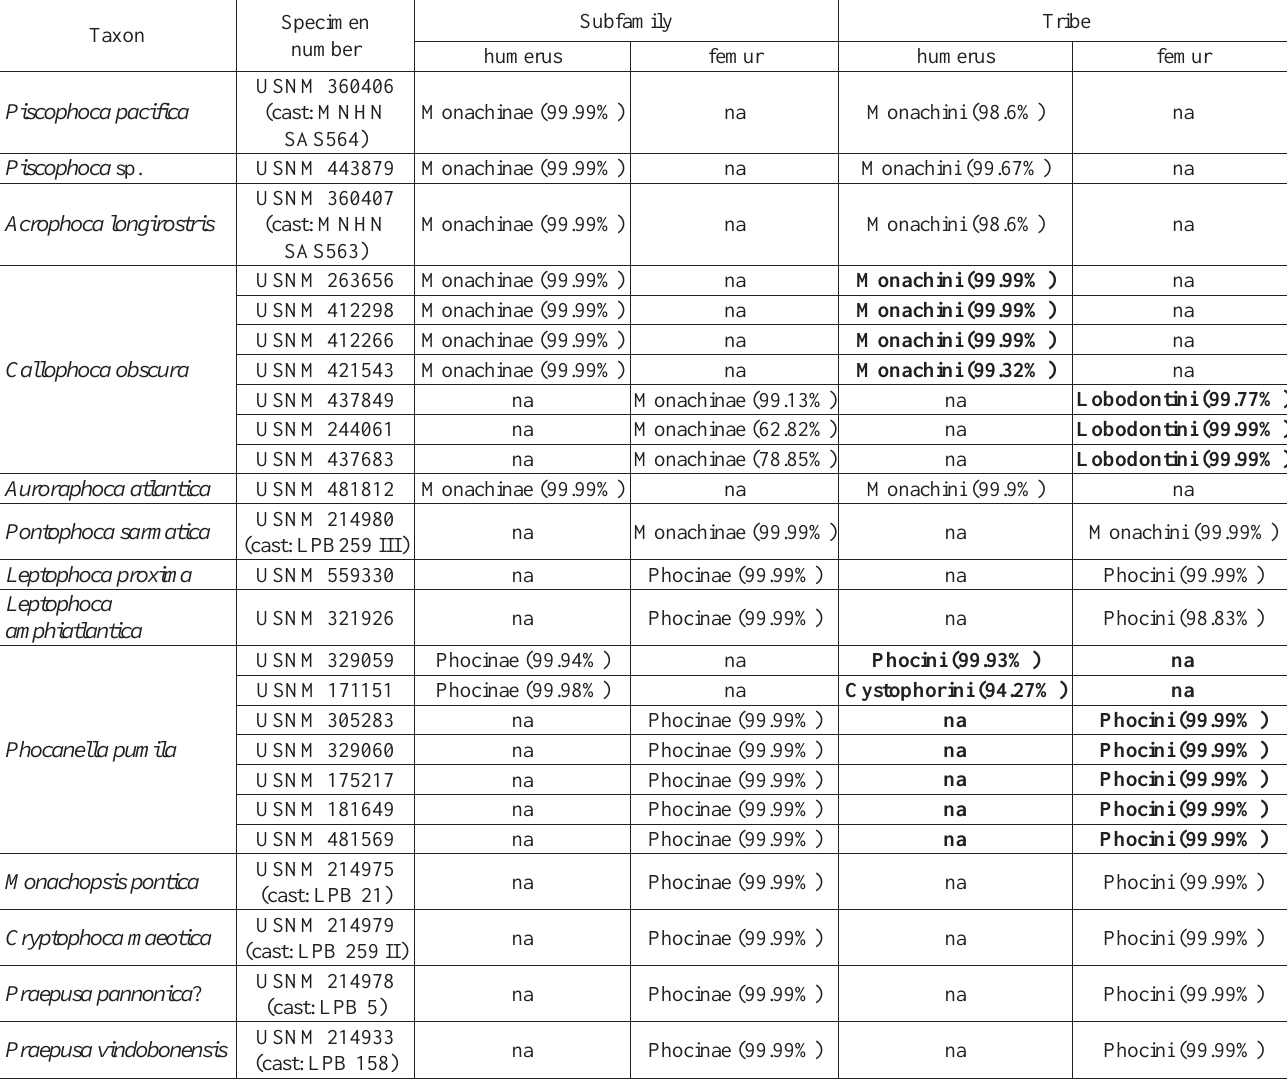
Table 2. Discriminant function analysis classification of fossil seals by subfamily and tribe. Taxa with discordance in classification, due to dif- ferences in results from humeral and femoral data, indicated in bold. Percents represent probability of correct classification; na, not available.